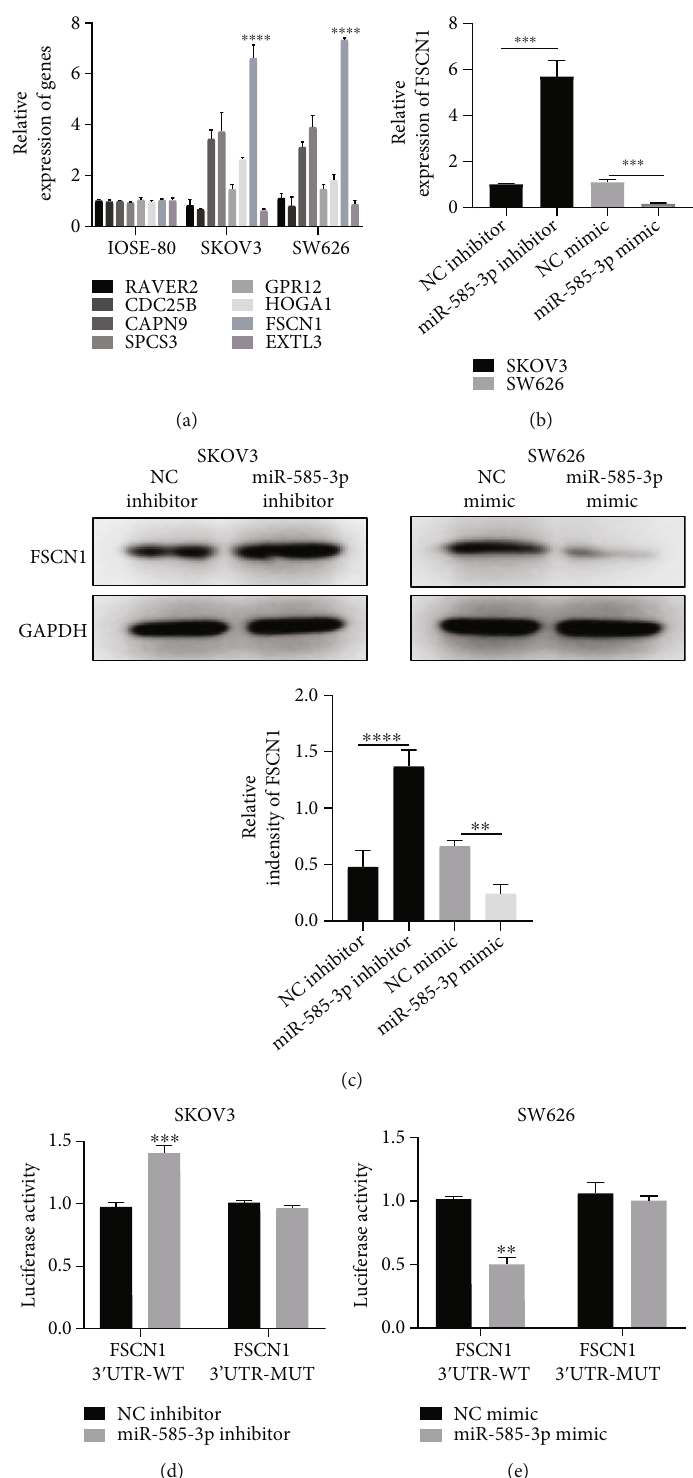
Figure 3: FSCN1 is the target gene of miR-585-3p. (a) qRT-PCR was used to detect the expression of target genes in OC cells and normal ovarian cells. (b) RT-PCR was used to detect the changes of FSCN1 expression after overexpression or interference of miR-585-3p. (c) Western blot was used to detect the expression of FSCN1 protein after miR-585-3p overexpression or interference. (d) The luciferase activity after cotransfection of miR-585-3p inhibitor and FSCN1 WT-3 ′ UTR was detected by double luciferase reporter assay in SKOV3 cell line. (e) The luciferase activity after cotransfection of miR-585-3p mimic and FSCN1 WT-3 ′ UTR was detected by double luciferase reporter assay in SW626 cell line. ∗∗ P < 0 : 01 , ∗∗∗ P < 0 : 001 , and ∗∗∗∗ P < 0 : 0001